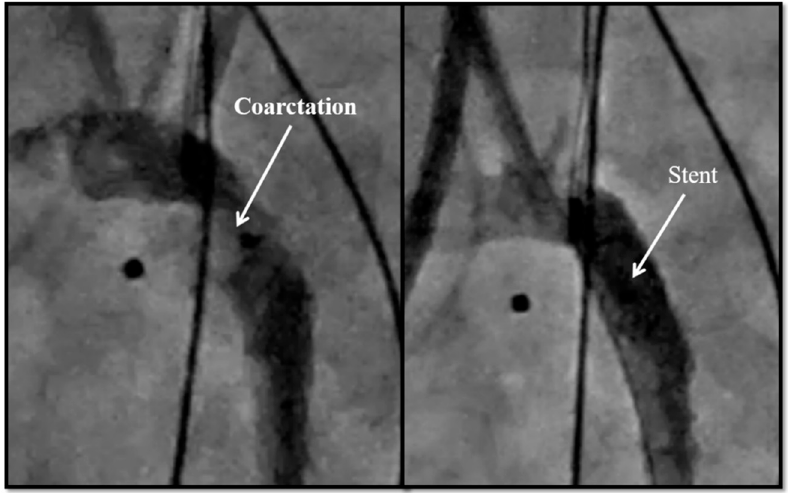
Figure 3. Aortic arch obstruction and subsequent stent placement in a 900 g infant.